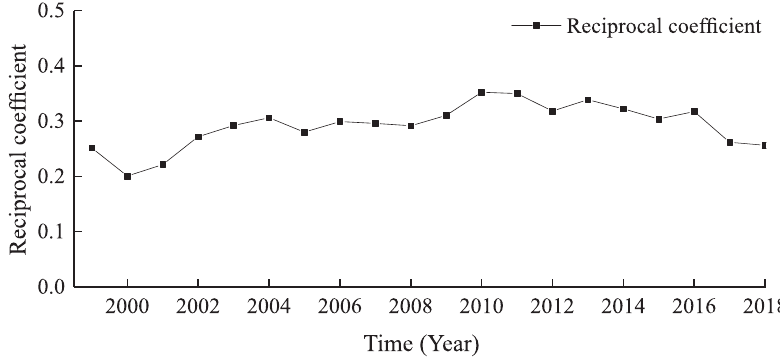
Figure 7. Reciprocal coefficients curve from 1999 to